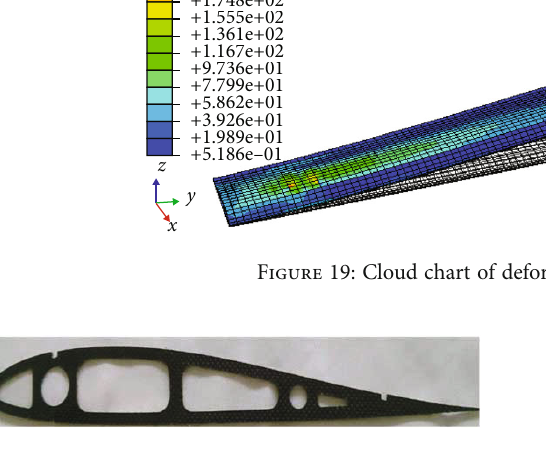
Figure 20: Wing rib of honeycomb sandwich plate structure.